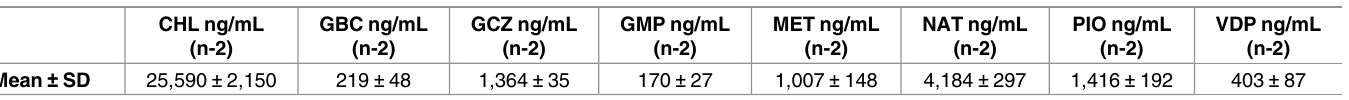
S1 Table. Concentrations of the spiking solutions for the standards used to prepare each calibration level and quality control levels. CHL, chlorpropamide; GBC, glibenclamide;